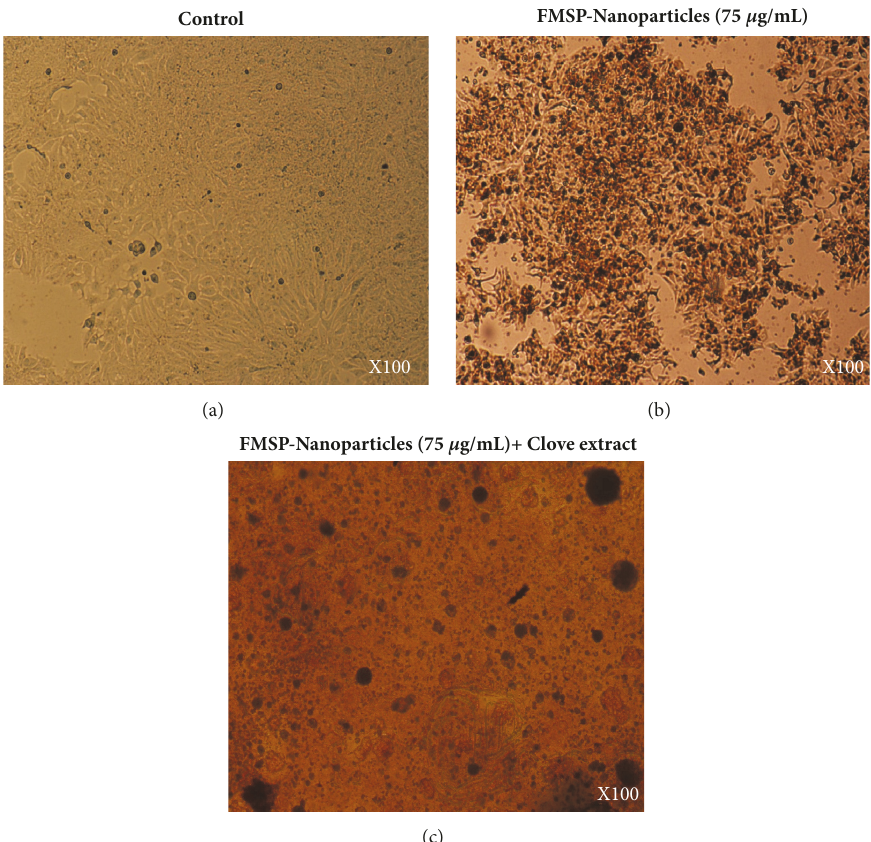
Figure 3: Cell morphology: the MCF-7 cells were analyzed 48hrs posttreatment. Figure (a) is control; Figure (b) is treated with FMSP- nanoparticles (75 𝜇 g/mL); Figure (c) is treated with FMSP-nanoparticles (75 𝜇 g/mL) + clove extracts (100 𝜇 g/mL). Arrows indicate cell dead cell debris. 100 X